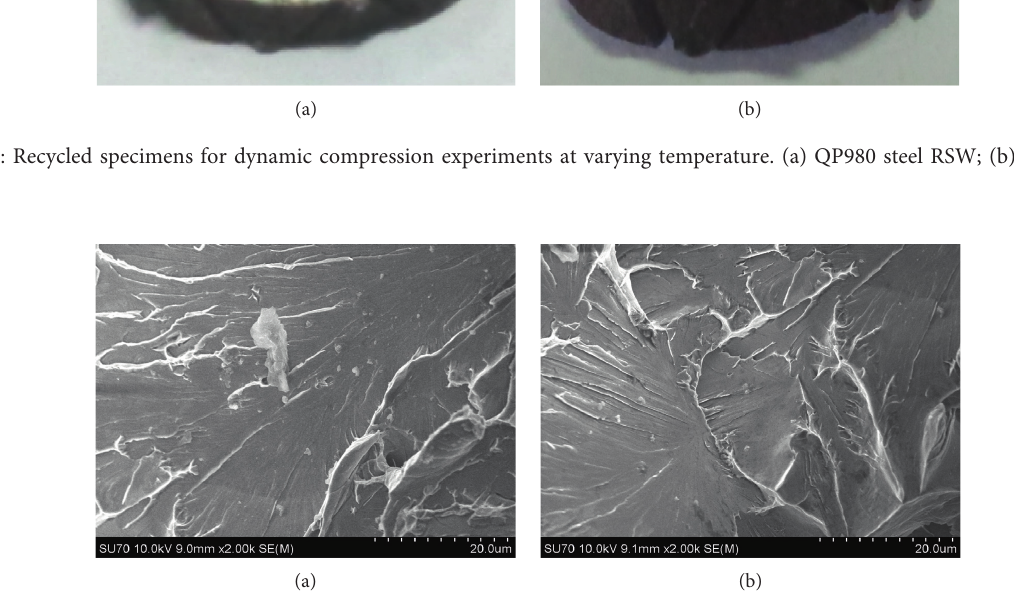
Figure 15: SEM results. (a) QP980 steel RSW; (b) TRIP800 steel RSW.